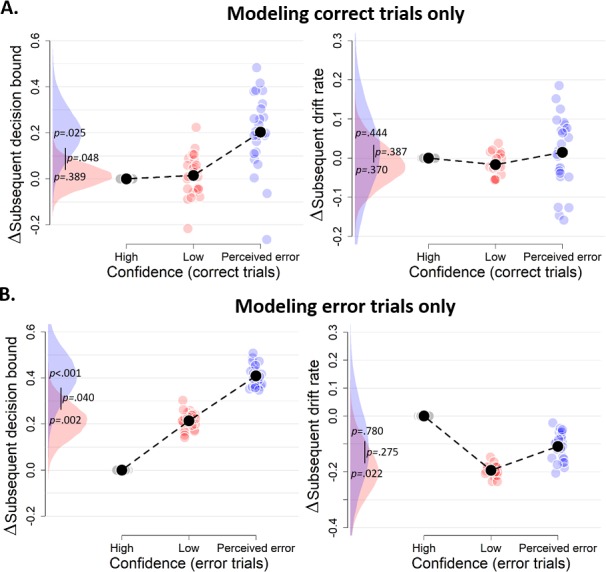
Confidence-dependent modulation of decision bound remains qualitatively similar when modeling only correct (A) or only error trials (B).Same conventions as in Figure 3. Note that, due to a lack of trials in one of the cells, results are based on 25 (A) and 24 (B) participants.